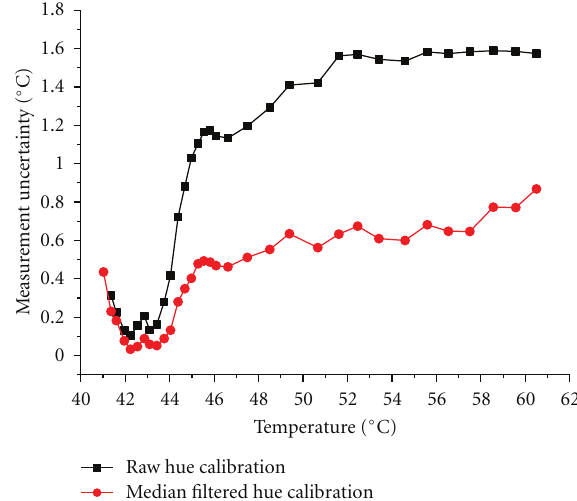
Figure 3: The measurement uncertainty in the raw hue and the median filtered hue calibrations.